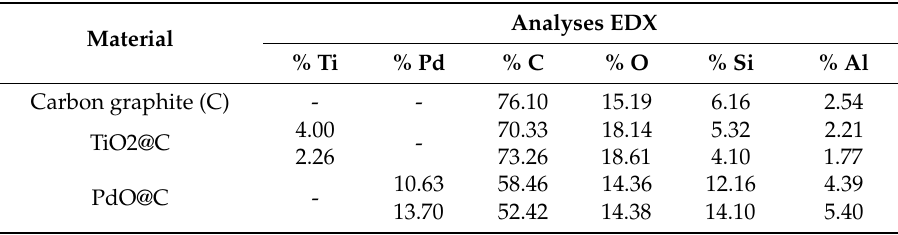
Table 1. Energy-dispersive X-ray (EDX) elementary results for comparison between unmodified graphite powder and nano-modified graphite